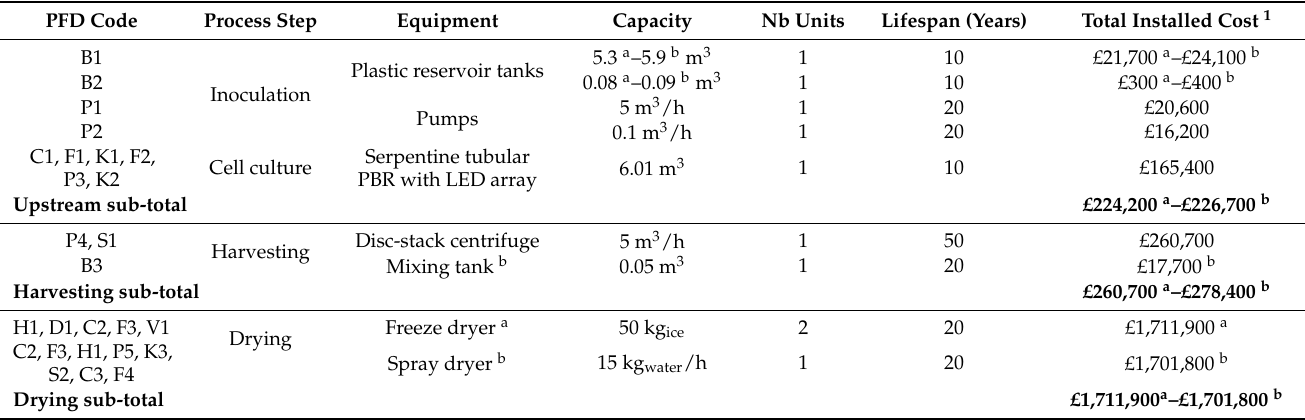
Table A1. Equipment sizing and associated capital costs for the freeze-drying and spray-drying strategies. Values provided in the upstream and harvesting sections are identical for both strategies unless otherwise stated.